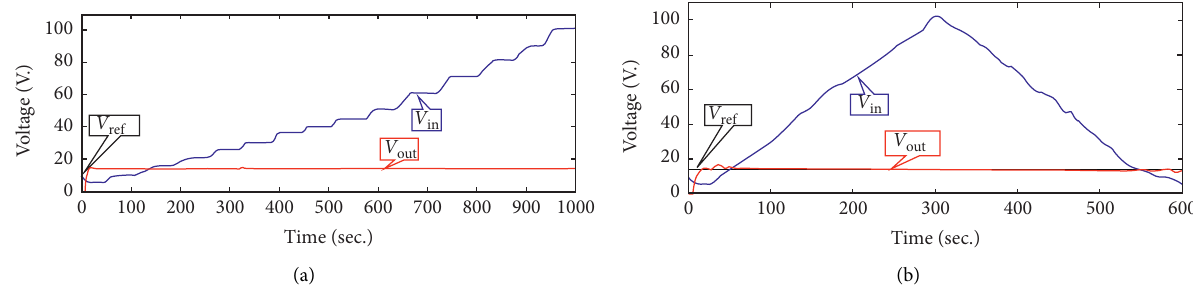
Figure 18: The output voltage response at no load. (a) The input supply voltage stair change varying from 5 to 100V. (b) The input supply voltage varying from 5 to 100V .